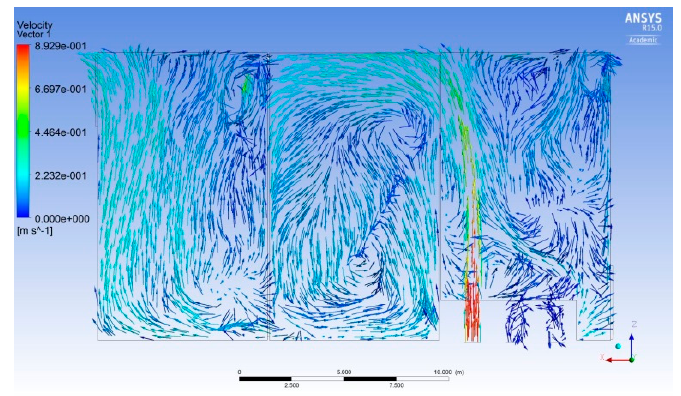
Figure 15. Velocity vector plot 5-m depth (reduced duration).